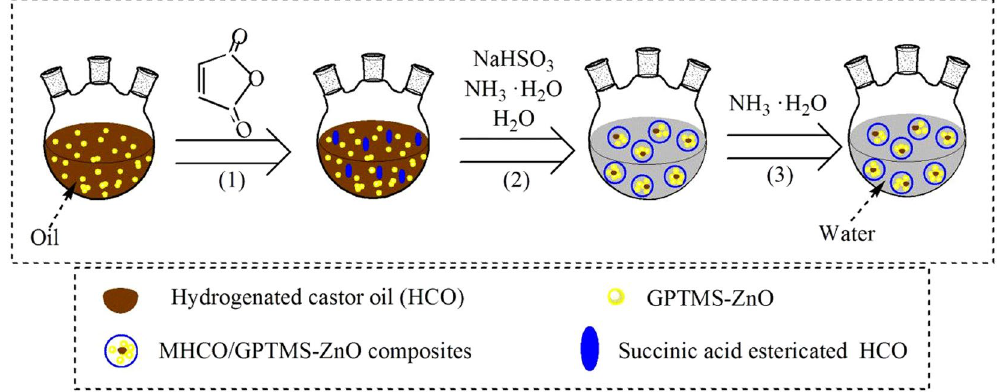
Figure 1. Schematic illustration of the formation of MHCO/GPTMS-ZnO